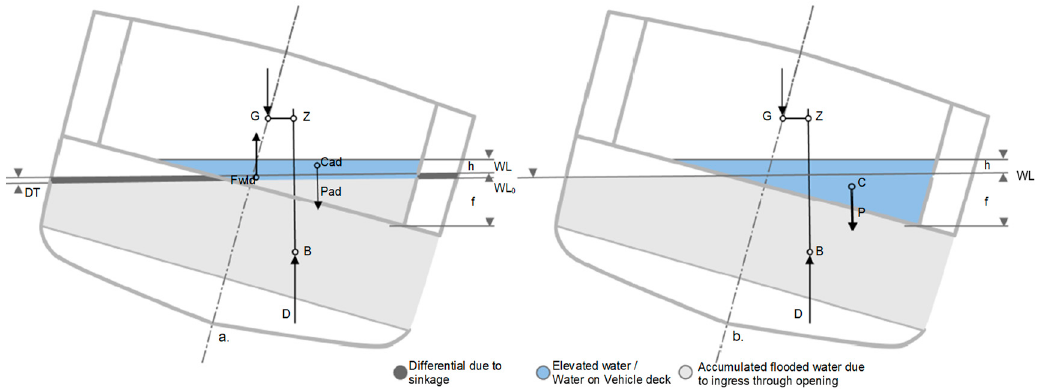
Figure 2. ( a ) Depiction of SEM parameters with water elevation in the vehicle deck at the point of no return (PNR)—case of RoPax; ( b ) normal method employed by damage stability software considering the floodwater volume as a total water on the vehicle deck inside an undamaged tank (NB: “This proposal was considered at IMO alongside the traditional statistical approach and the latter prevailed but with the height of water on deck estimated on the basis of the expression (2), deriving from purposely-conducted model experiments at Danish Maritime Institute and Strathclyde University”).